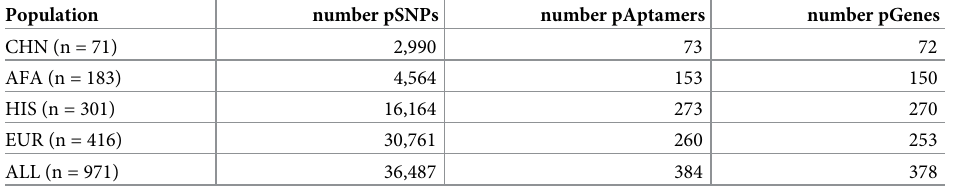
Table 1. pQTL counts (FDR < 0.05) in TOPMed MESA populations. Some proteins had more than one aptamer tar- geting